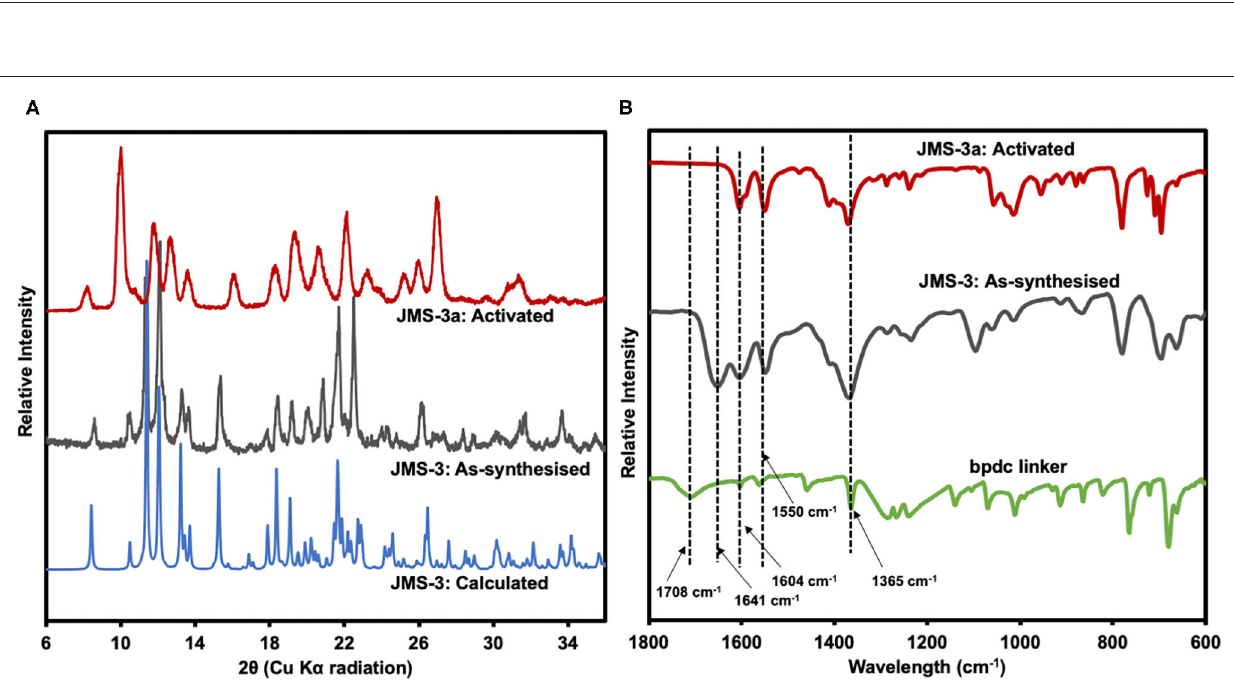
Frontiers in Chemistry |